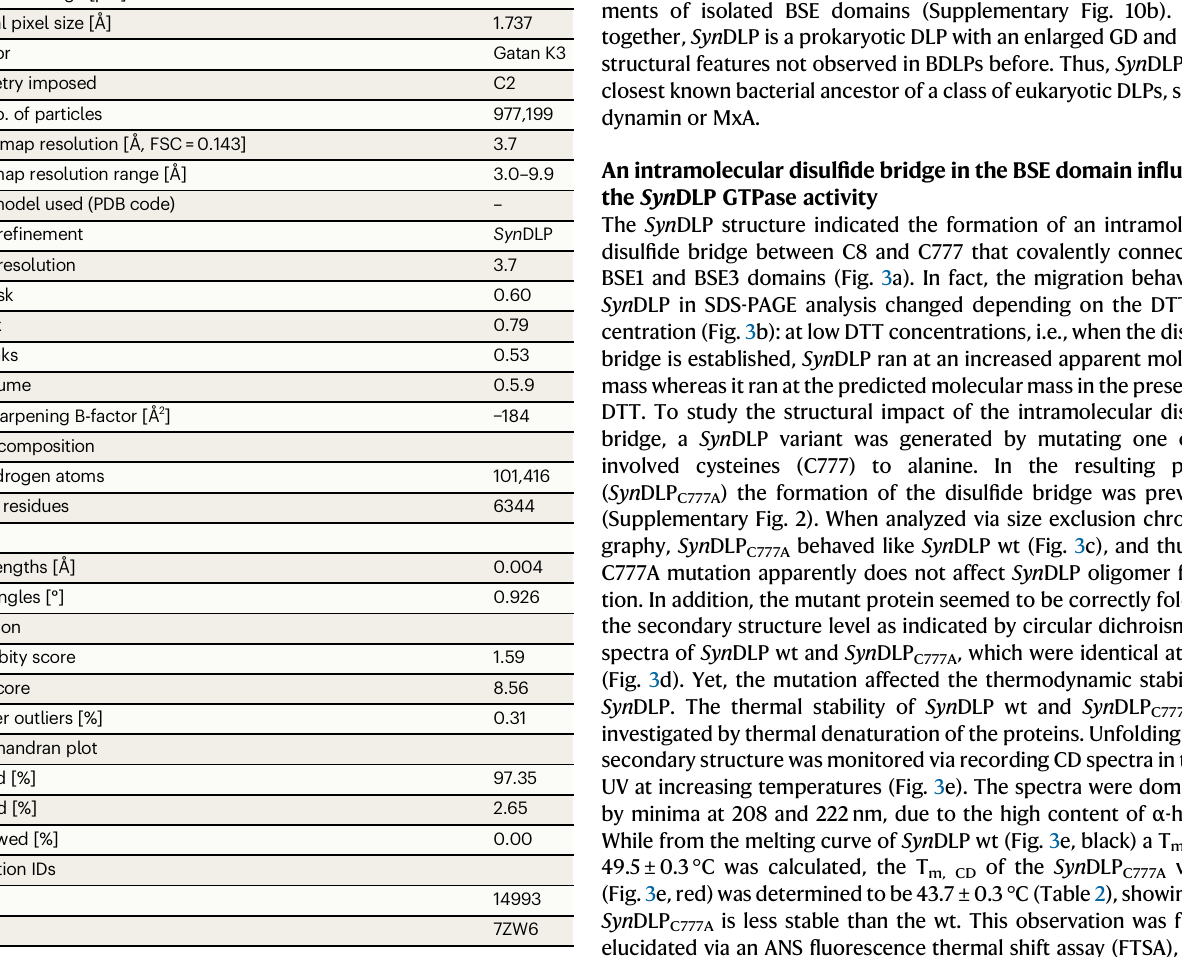
Table 1 | Cryo-EM data collection and re fi nement statistics Data collection and